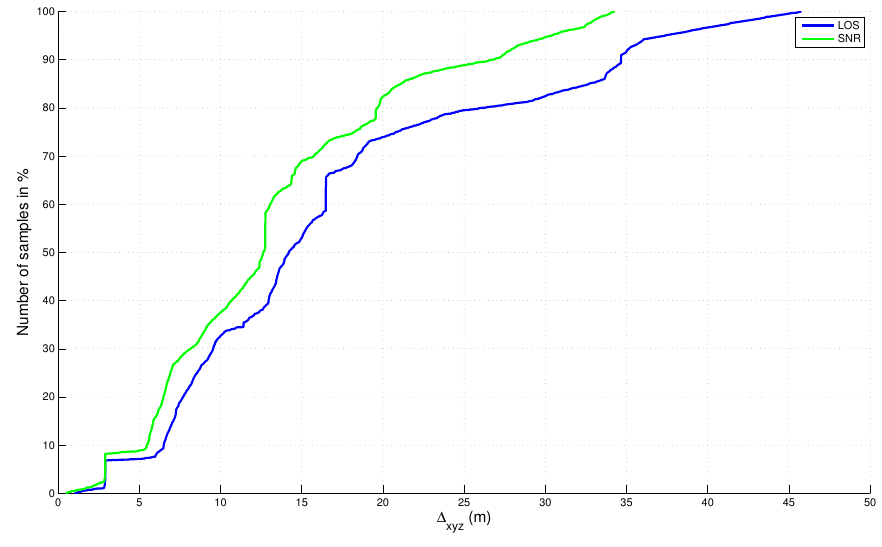
Figure 9. Cumulative distribution function of the absolute error in 3D for “free” solutions (without